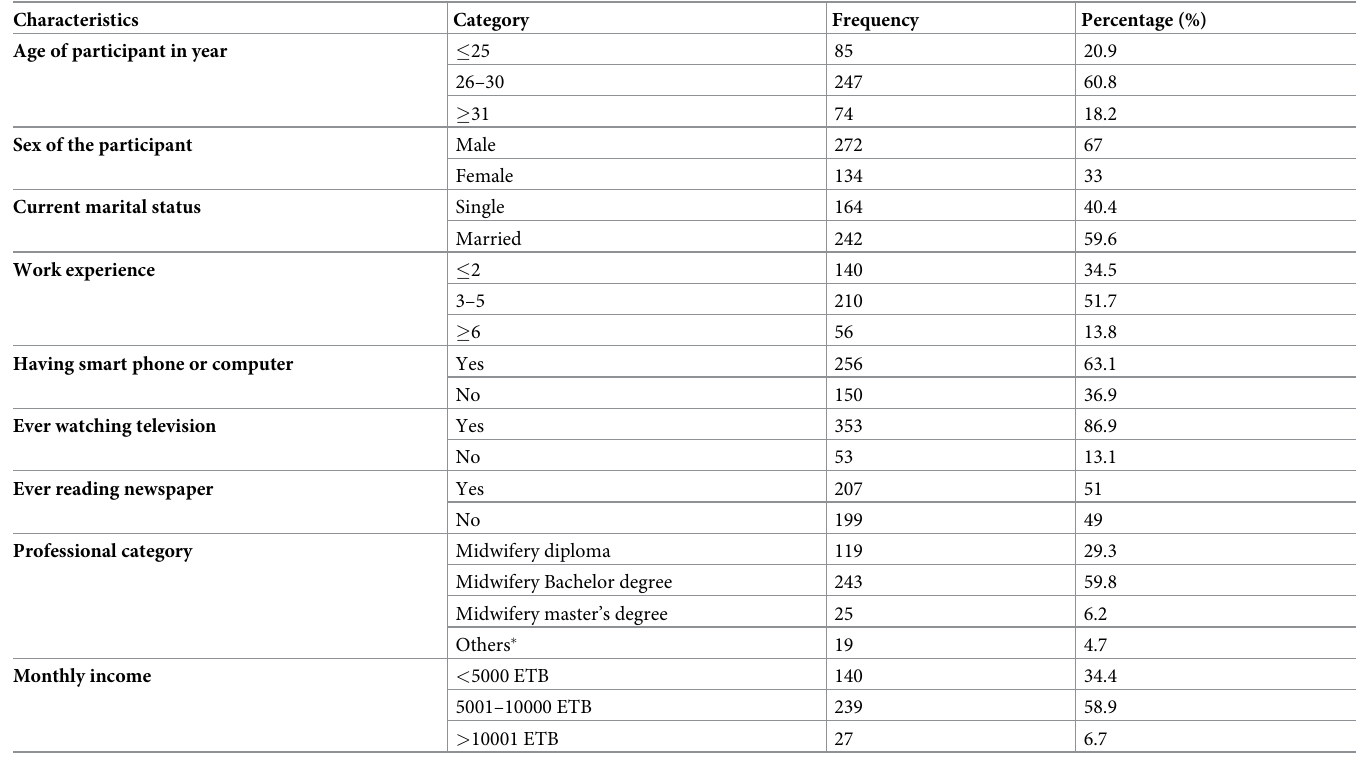
Table 1. Socio-demographic characteristics of study participants in Gondar province hospitals, northwest Ethiopia, 2020/2021 (n =